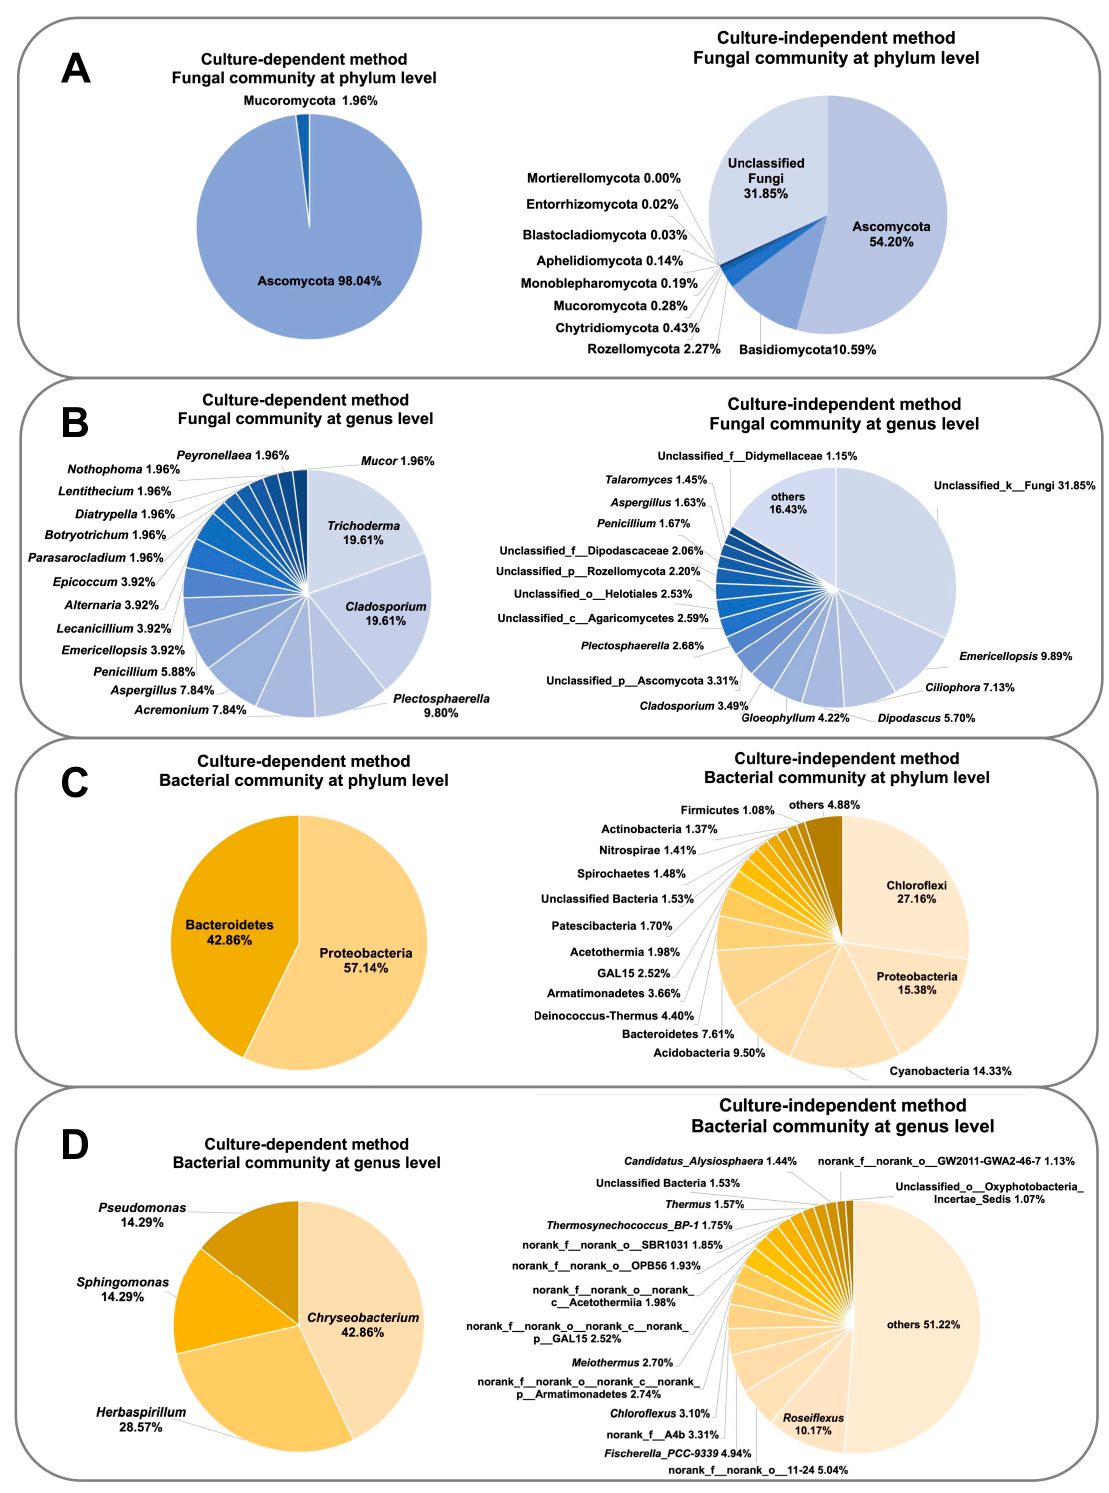
Figure 11. Comparison of culture-dependent and culture-independent analysis methods of the fungal community at the phylum ( A ) and genus ( B ) levels, and the bacterial community at the phylum ( C ) and genus ( D ) levels. In the taxa names, “d” = domain, “k” = kingdom, “p” = phylum, “c” = class, “o” = order, and “f” =